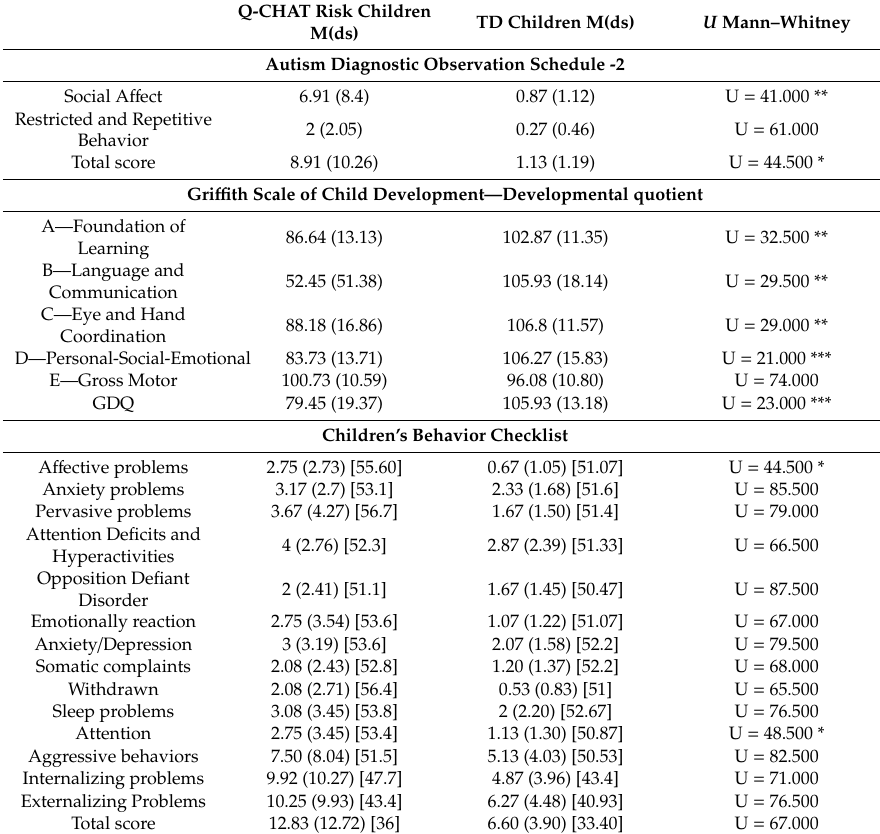
Table 4. Mean scores, standard deviation, and Mann–Whitney U